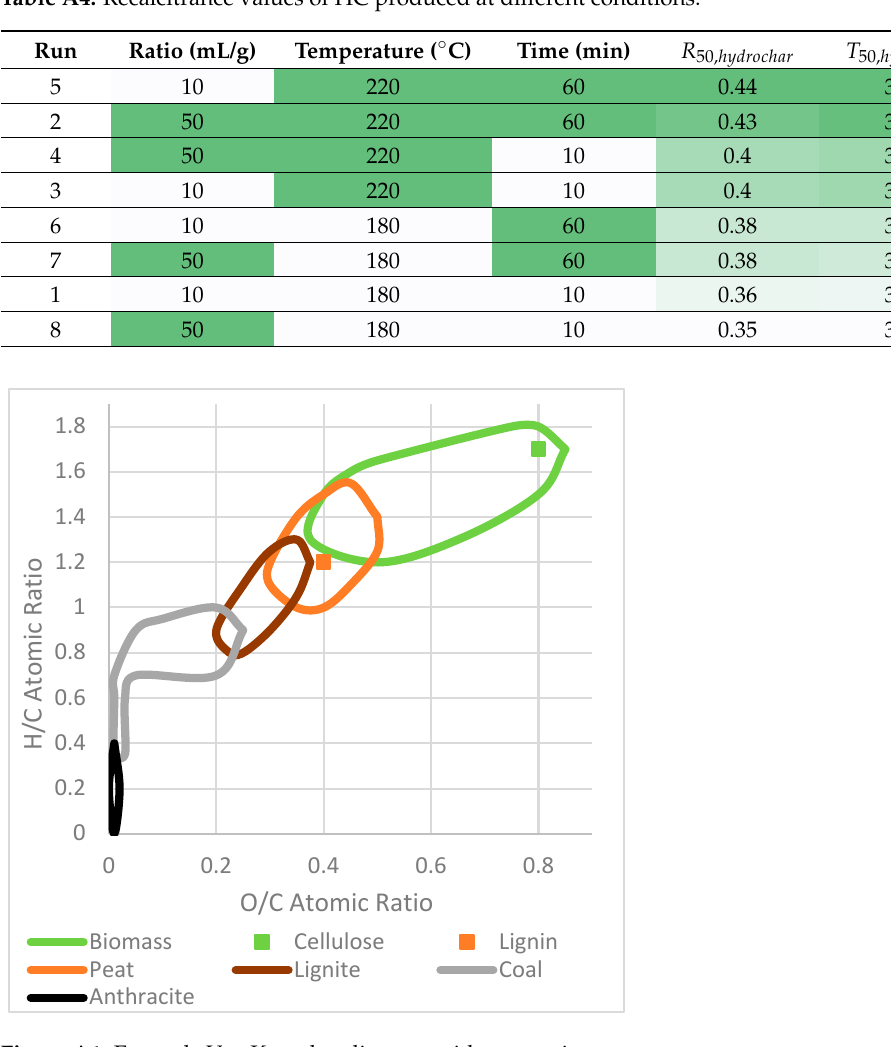
Figure A1. Example Van Krevalen diagram with annotation. Table A6. Comparison of recent methods to produce HC and results.